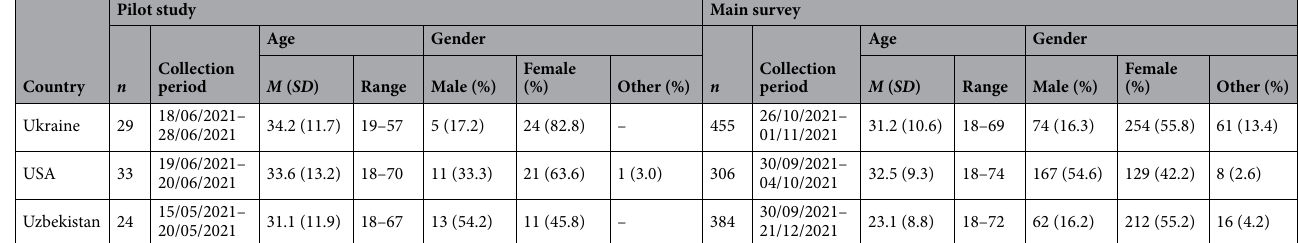
Table 4. Demographic composition for each country in the pilot study and main survey. Percentages may not add up to 100% for gender due to the exclusion of missings or ‘prefer not to say’ responses. Data were collected online in all countries, with the exception of the main survey in Turkey, where we partially used paper-and- pencil questionnaires. a Data collection was paused from 13/08/2021 to